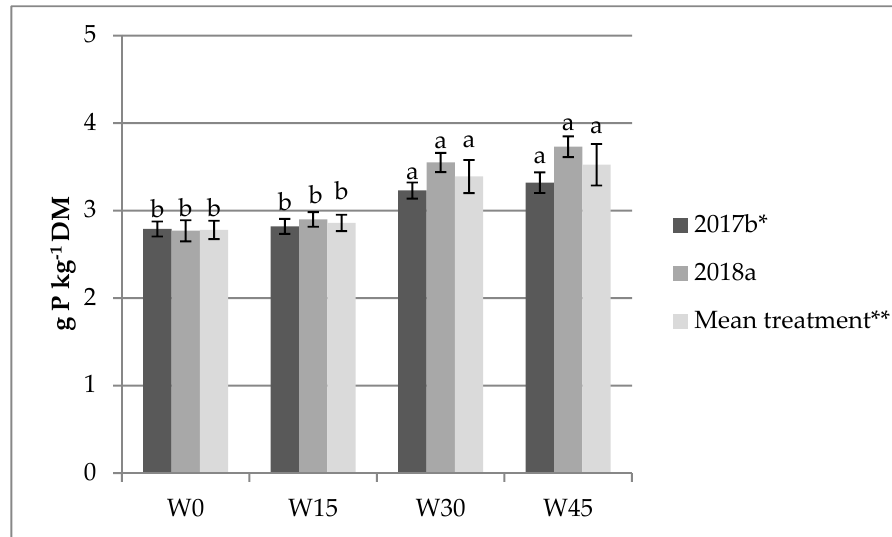
Figure 2. Nitrogen content in maize grain. W0—the control with no stillage treatment, W15—15 m 3 of stillage per hectare, W30—30 m 3 of stillage per hectare, W45—45 m 3 of stillage per hectare. * means of years regardless of treatments; ** means of treatments regardless of years.